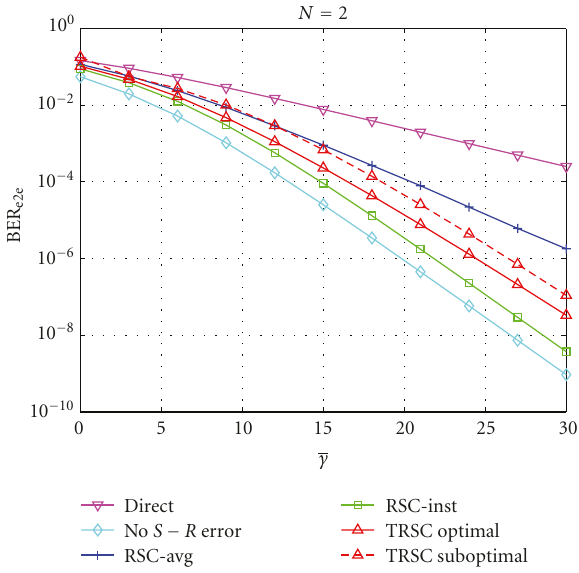
Figure 3: The e2e BER for all relaying protocols for N = 2 relays. The BER of direct transmission and the BER in the absence of errors in the S − R i links are also shown as reference